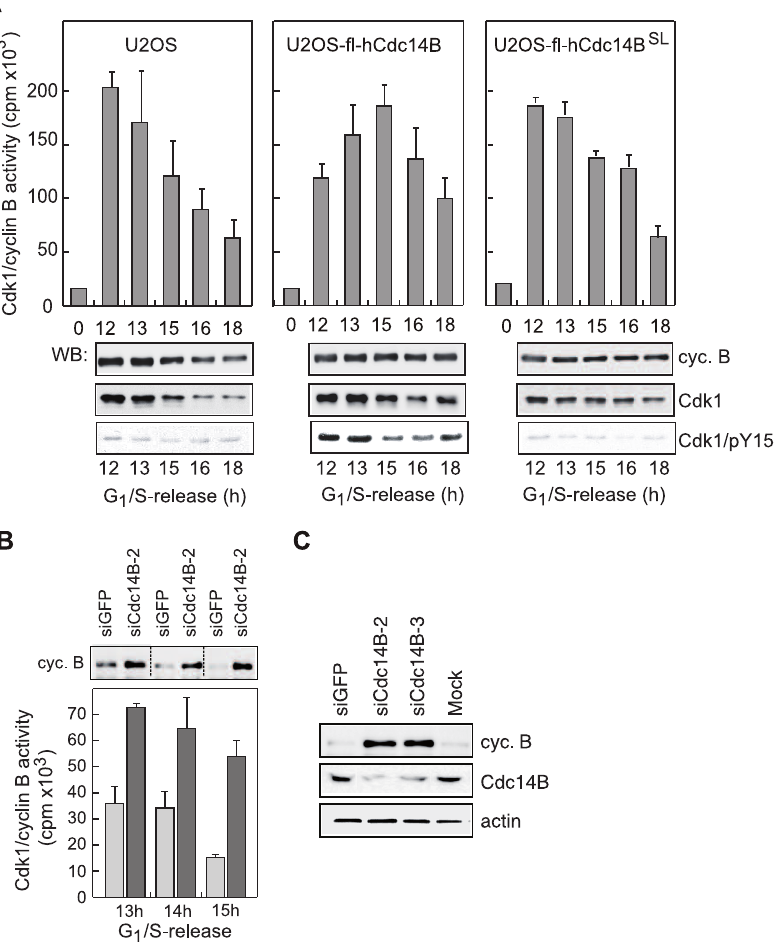
Figure 5. hCdc14B regulates Cdk1/cyclin B activity. A . Overexpression of hCdc14B alters Cdk1/cyclin B activity. Cdk1/cyclin B was immunopurified from U2OS, U2OS-fl-hCdc14B and U2OS-fl-hCdc14B SL cells that were synchronized at G 1 /S (0 h) and released for the indicated times. Kinase activity was assayed in vitro using Cdk1-specific peptides and 32 P-ATP. Values were normalized to the activity of Cdk1/cyclin B in G 1 /S cells. The Western blots show the amount of immunoprecipitated cyclin B, Cdk1 and Cdk1/pY15. B . Depletion of hCdc14B increases Cdk1/cyclin B activity. Cells were transfected with GFP- (siGFP, light bars) or hCdc14B-specific siRNA-2 (siCdc14B-2, dark bars) and arrested by double thymidine block. Kinase activity of immunopurified Cdk1/cyclin B was assayed in vitro at the indicated times (h) after release from G 1 /S. The immunoblot on the top shows the amounts of cyclin B used in the assays. C . Cyclin B is stabilized upon knockdown of hCdc14B. Cells were transfected with siRNAs against GFP (siGFP), hCdc14B (siCdc14B-2 and siCdc14B-3) or left untransfected (mock), synchronized by double thymidine block, released from G 1 /S for 16 h and analyzed on immunoblots.